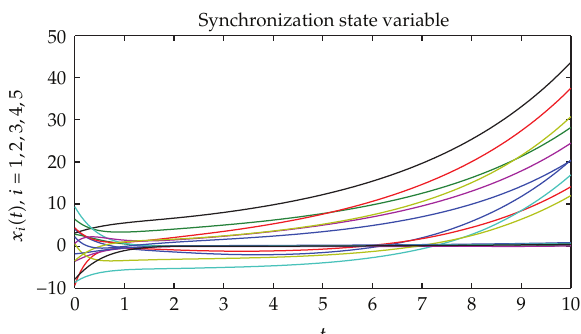
Figure 5: The state variables x i 1 (cid:7) t (cid:8) , x i 2 (cid:7) t (cid:8) , and x i 3 (cid:7) t (cid:8) without impulsive e ff